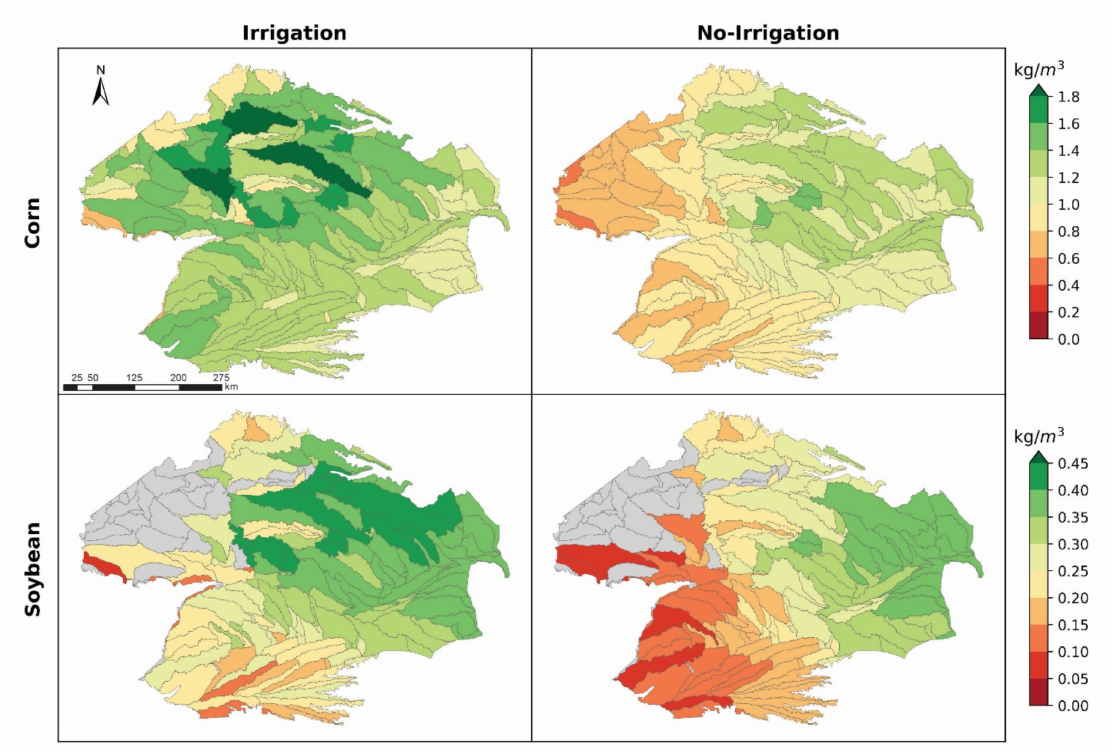
Figure 12. Simulated average annual values of crop water productivity for corn and soybean in the irrigation and no-irrigation scenarios. Gray shades represent regions without corn or soybean